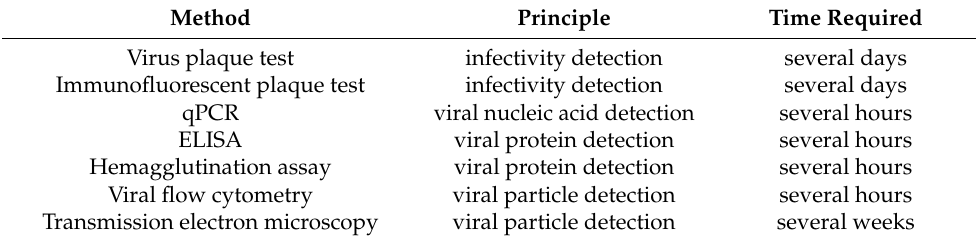
Table 1. Advantages and drawbacks of traditional virus detection